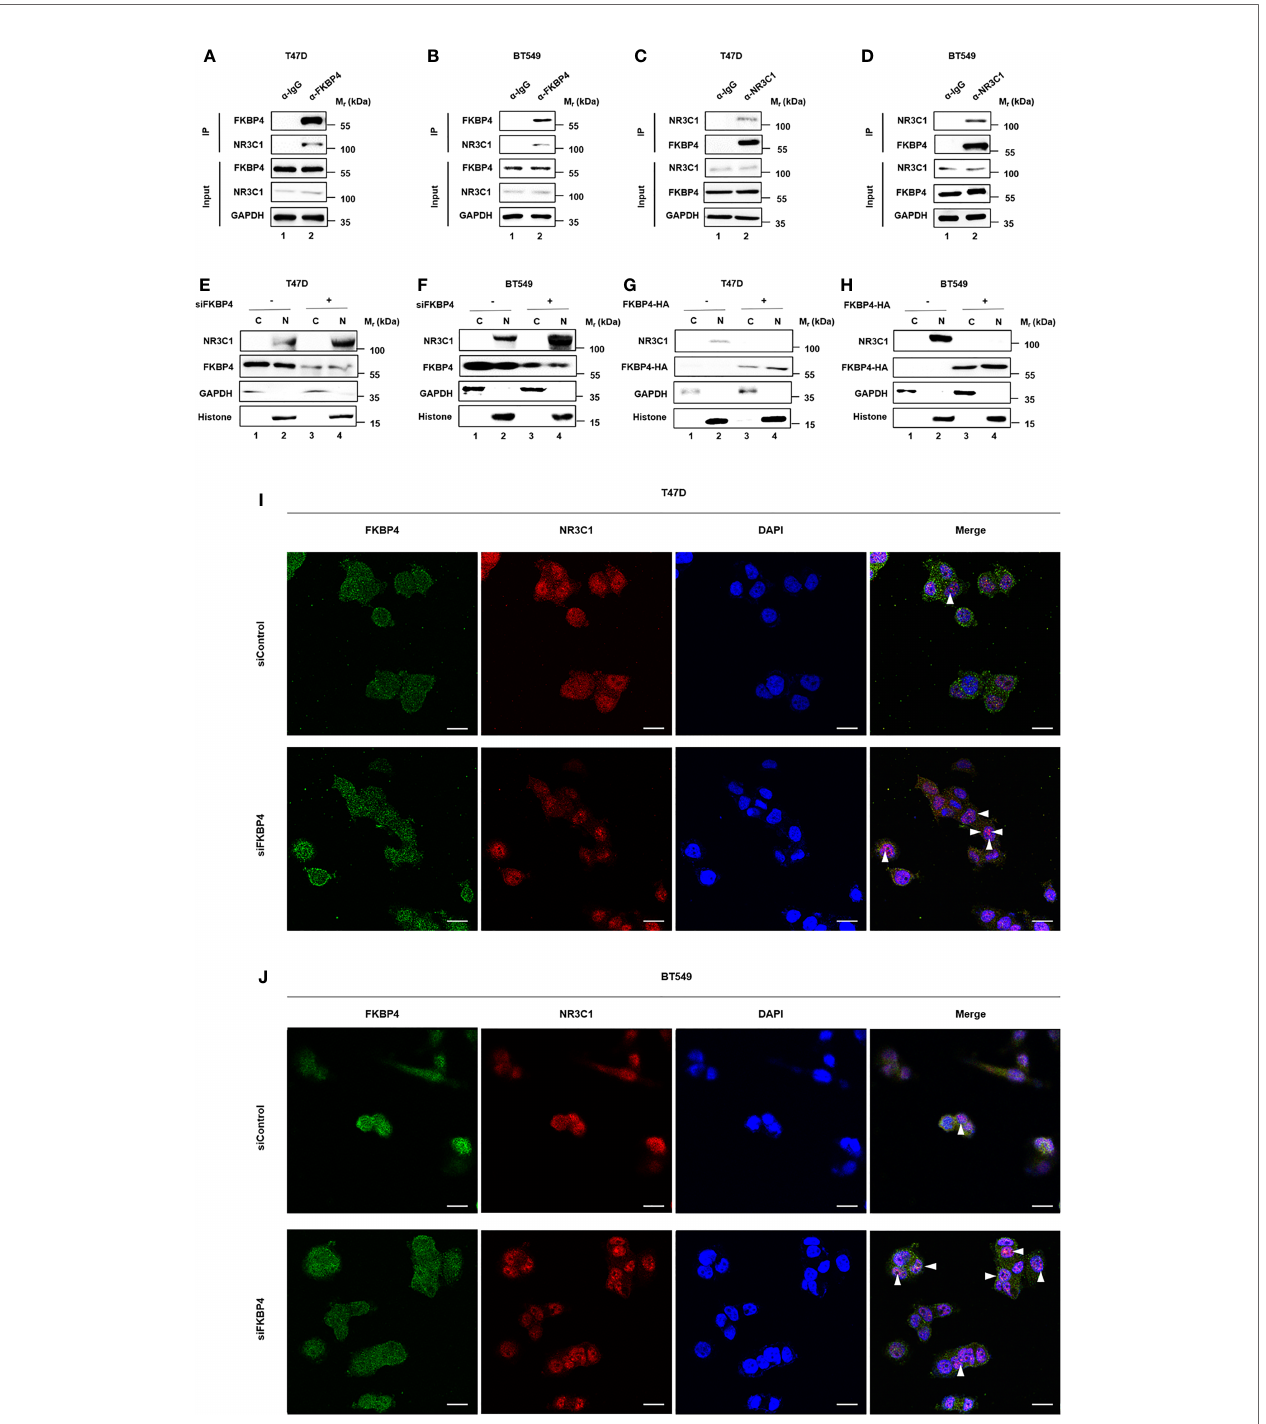
FIGURE 3 | FKBP4 binds to NR3C1 and FKBP4 inhibition triggers nuclear translocation of NR3C1. (A – D) co-IP and western blot assays using antibodies as indicated for binding between endogenous FKBP4 and NR3C1 in T47D and BT549 cells. (E – H) T47D and BT549 cells were transfected with siRNAs or plasmids. Cells were harvested, and the nuclear and cytoplasmic fractions were separated. Proteins were analyzed by immunoblotting using anti-NR3C1, anti-FKBP4, anti- GAPDH, or anti-histone antibody. (I, J) T47D and BT549 cells were transfected with FKBP4 siRNAs. Immuno fl uorescent staining was carried out using anti-NR3C1 and anti-FKBP4. DAPI staining was performed to show the nuclei (n = 3 independent biological replicates). The arrowheads show the NR3C1 nuclear localization under FKBP4 inhibition. Scale bar = 20 m